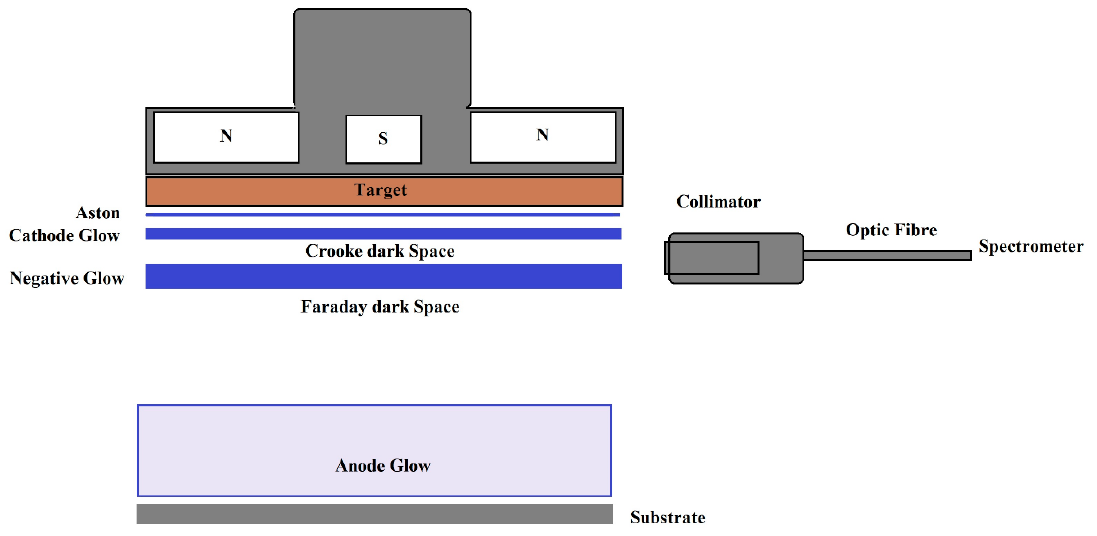
Figure 1. Layers of a plasma glow discharge.